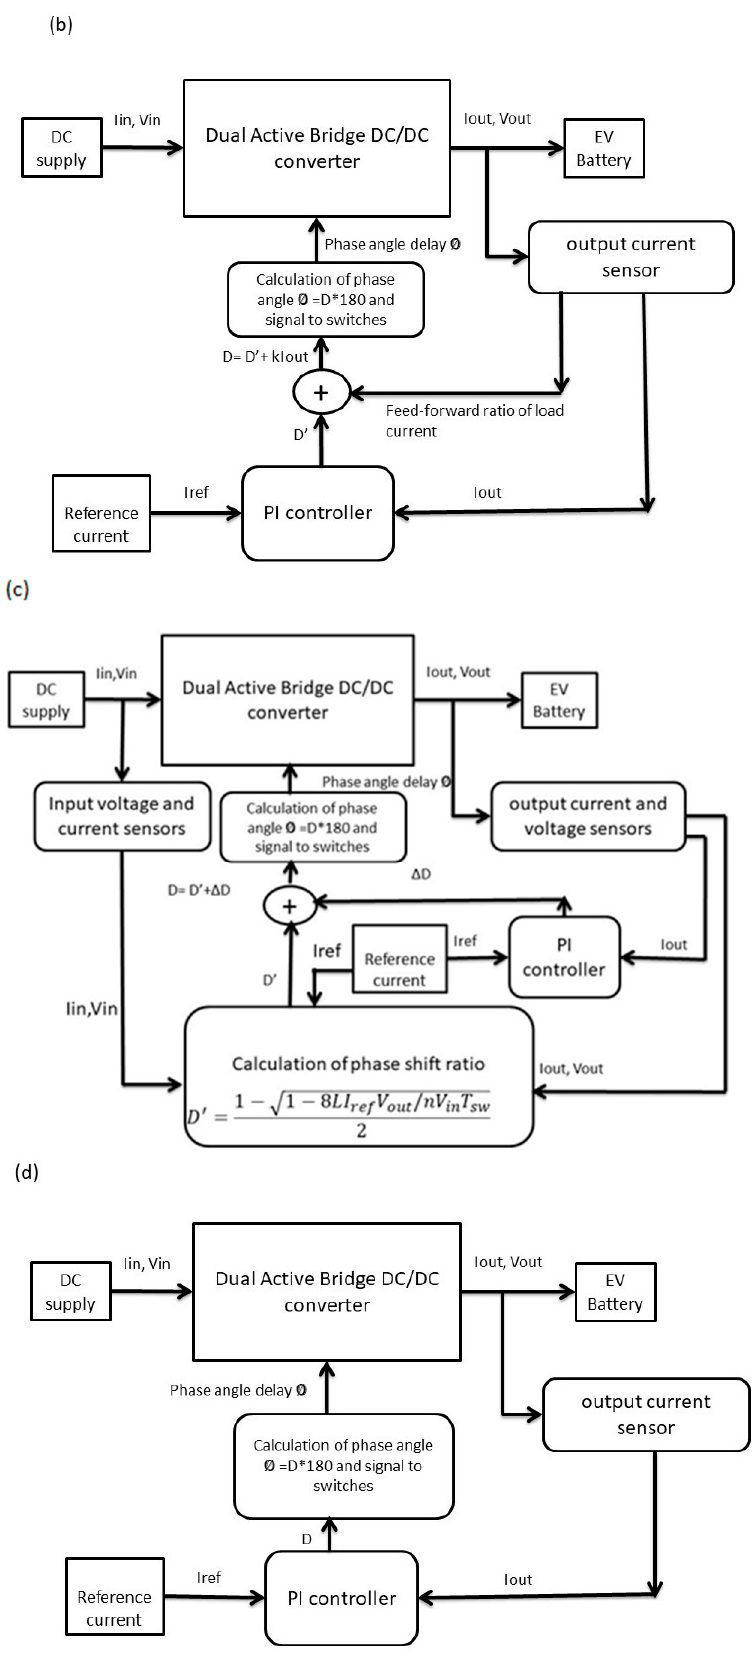
Figure 8. Block diagram of control schemes: ( a ) FCC; ( b ) LCFF; ( c ) MBPS; ( d ) PI.